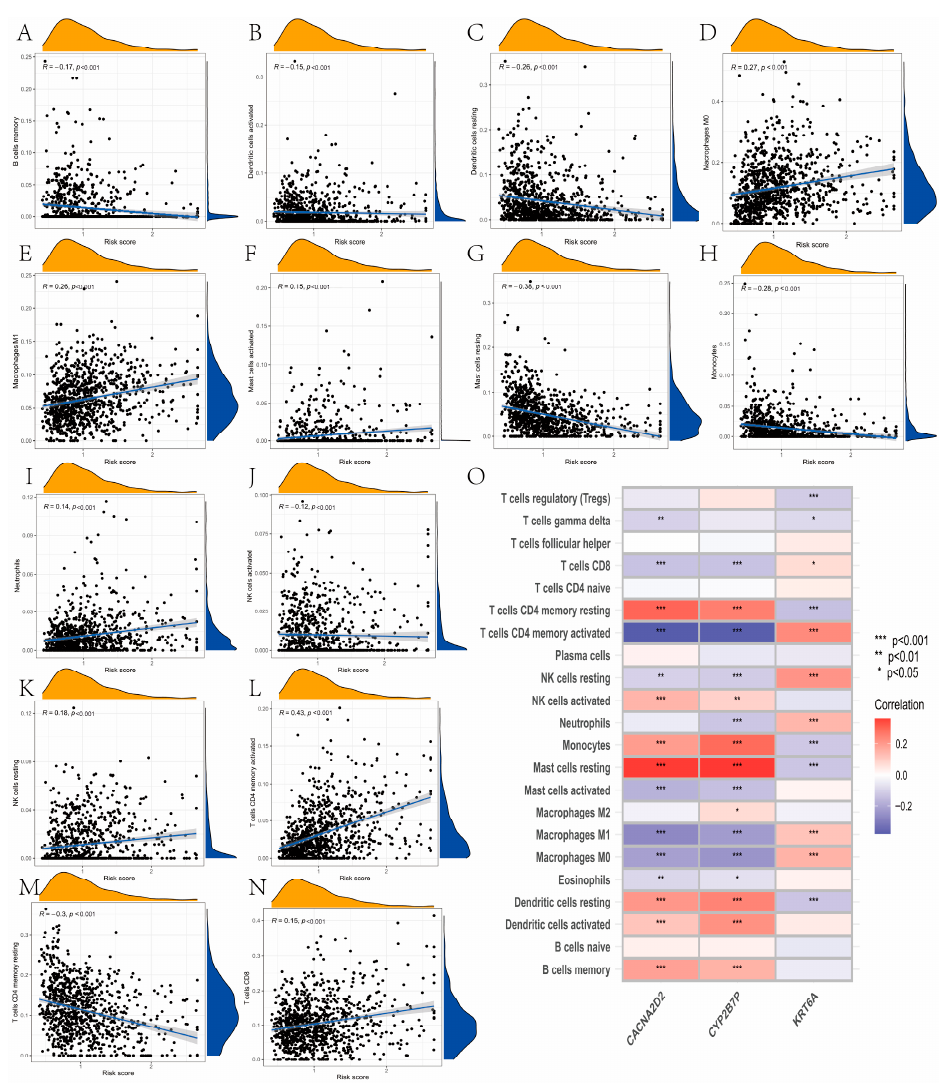
Figure 7. Evaluation of cell infiltration between the high- and low-risk groups. ( A – N ) Correlations between immune cell types and risk score using Spearman’s correlation analysis. The risk score was negatively correlated with memory resting T cells CD4, activated NK cells, monocytes, resting mast cells, resting dendritic cells, activated dendritic cells, and B cells’ memory. Additionally, the risk score was positively associated with T cells CD8, memory activated T cells CD4, resting NK cells, neutrophils, activated mast cells, macrophage M1, and macrophage M0. ( O ) These three genes selected in the prognostic model were significantly related to most immune cells using Spearman’s correlation analysis. * P < 0.05, ** P < 0.01, *** P <